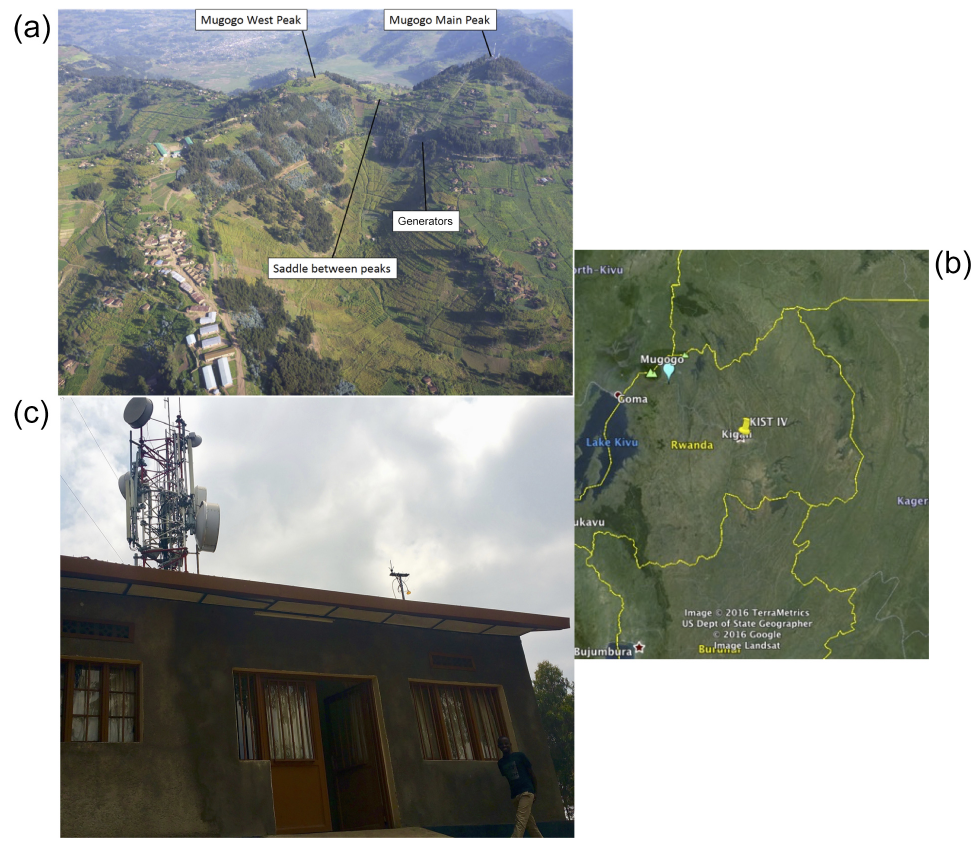
Figure 2. From top left moving counterclockwise: an aerial view of RCO at Mt. Mugogo Main Peak, the station with towers in the back- ground, and the location of Mt. Mugogo in Rwanda (blue pin) in relation to Kigali (yellow pin). Table 1. Instruments used in this study and measurement period used for